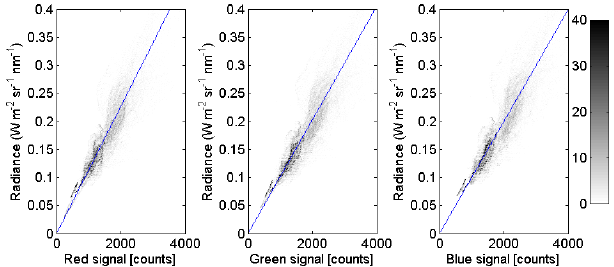
Figure 4. SHDOM radiance ( I (cid:49)λ (ϑ z ,ϑ s )) vs. USI pixel signal value ( v(ϑ z ,ϑ s )) . Dots with grayscale indicate density while the blue line is the best fit line.